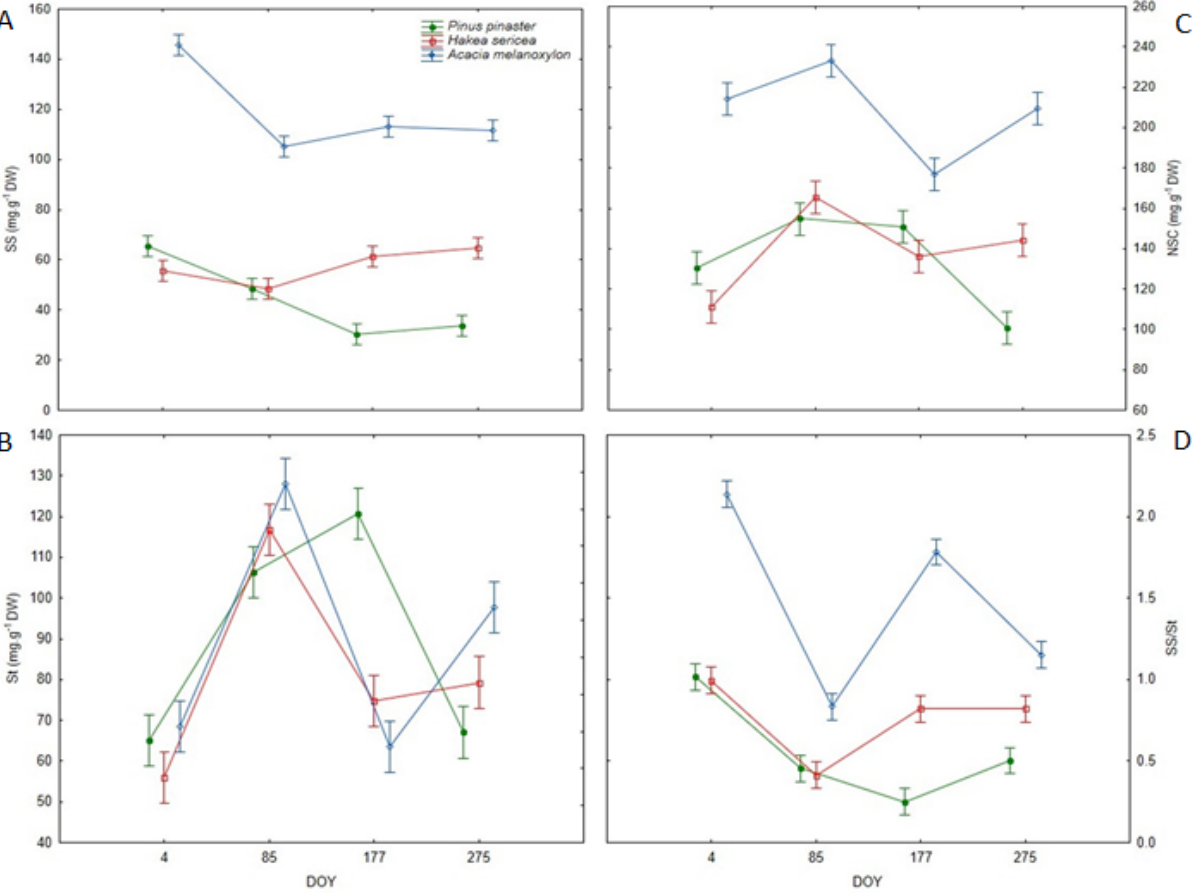
Figure 4. ( A ) Soluble sugars (SS), ( B ) starch (St), and ( C ) non-structural carbohydrate (NSC) content, and the ( D ) soluble sugars/starch ratio (SS/St) in the leaves of all analyzed species ( Pinus pinaster , Hakea sericea and Acacia melanoxylon ) on the four sampling dates.